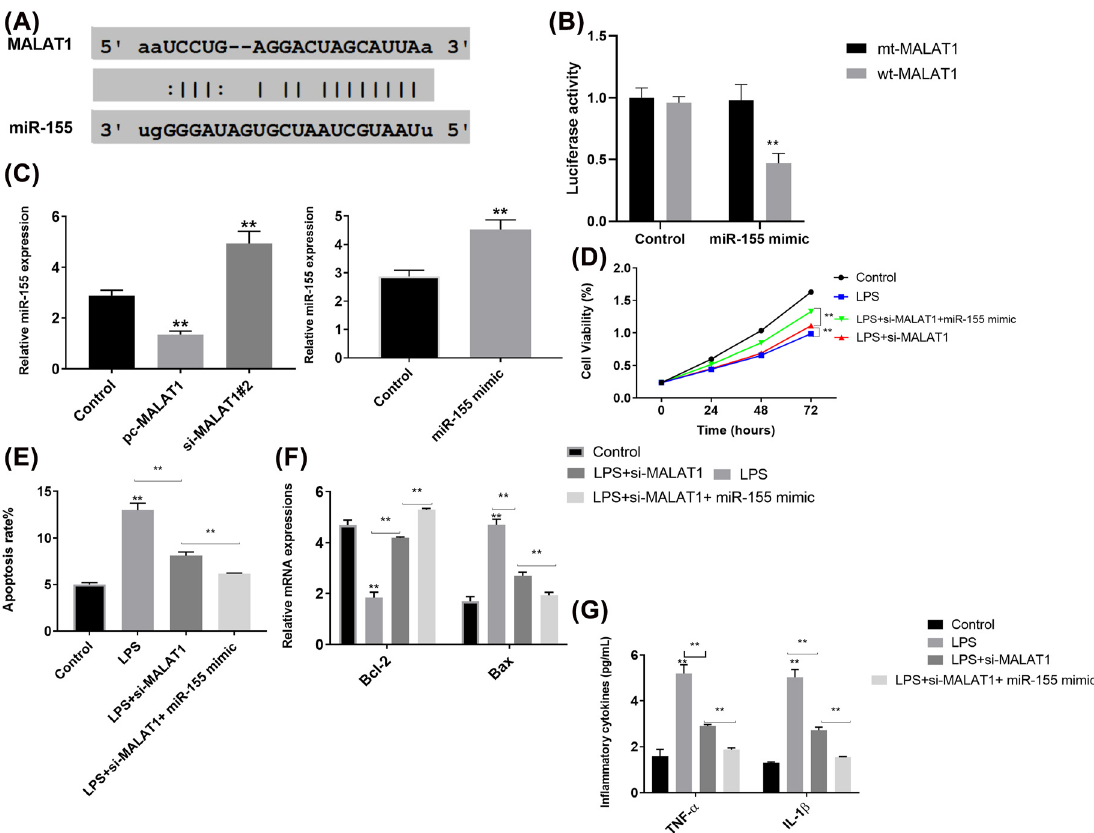
Figure3: Metastasis-associatedlungadenocarcinomatranscript1(MALAT1)spongedmiR-155to regulateprogressionsoflipopolysaccharide (LPS) induction in periodontal ligament cells (PDLCs). (A) Bindingspotsof miR-155 with MALAT1. (B) Luciferase activities inNC/miR-155mimicMALAT1-wt/mut. (C) MiR-155expressions with MALAT1 overexpression or suppression and miR-155 mimics. (D, E) Cell viability and apoptosis with si-MALAT1 and siMALAT1 with miR-155 mimics. (F) Bax and Bcl-2 with si-MALAT1 and siMALAT1 with miR-155 mimics. (G) TNF- α and IL-1 β with si-MALAT1 and siMALAT1 with miR-155 mimics. ** p<0.05 was statistically signi fi